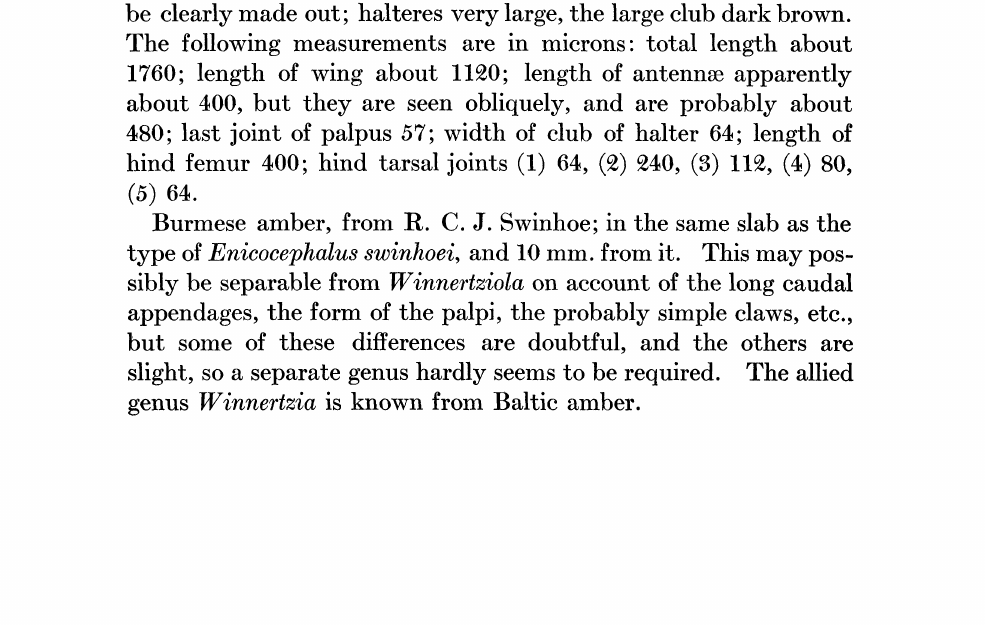
face markings cannot be determined; the three joints before the last broader basally than apically; palpi large, apparently jointed, but there is probably a small basal joint not seen, joint before the last not ap- preciably shorter than